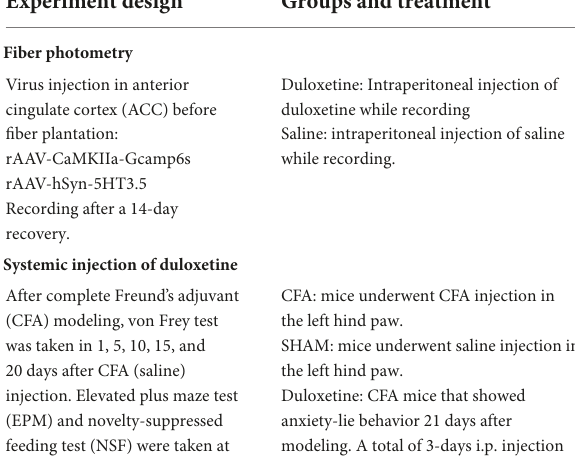
TABLE 1 Outline of experimental design. Experiment